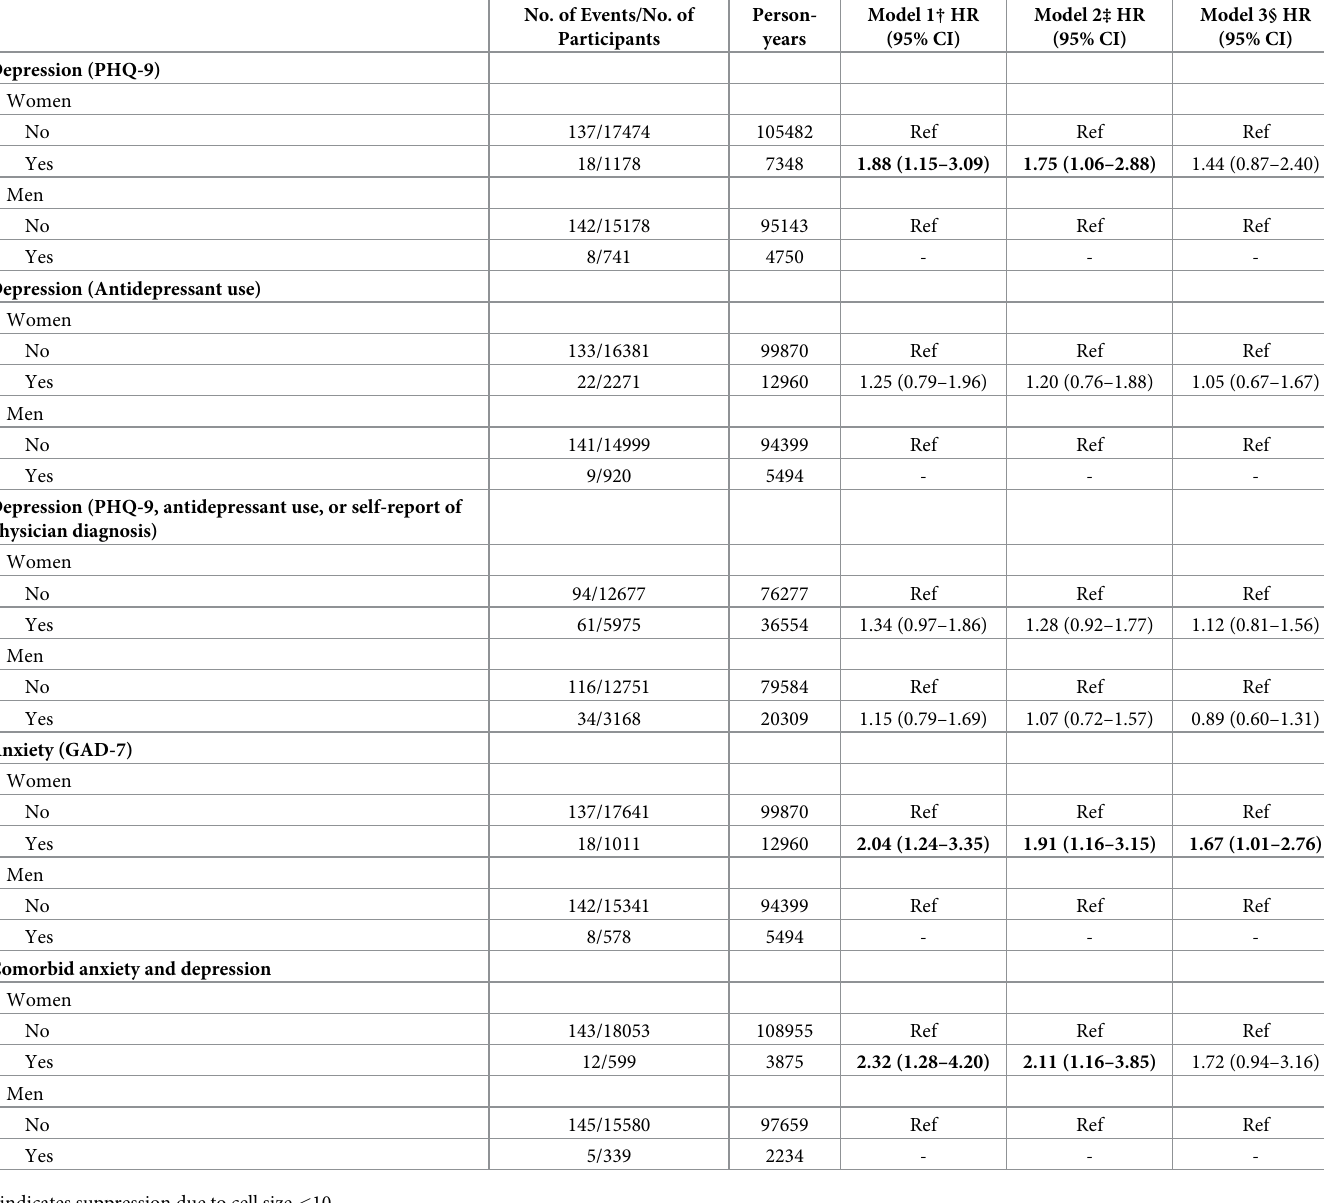
Table 6. Hazard ratios between mental health disorders and subsequent diagnosis of lung cancer, stratified by sex. No. of Events/No. of